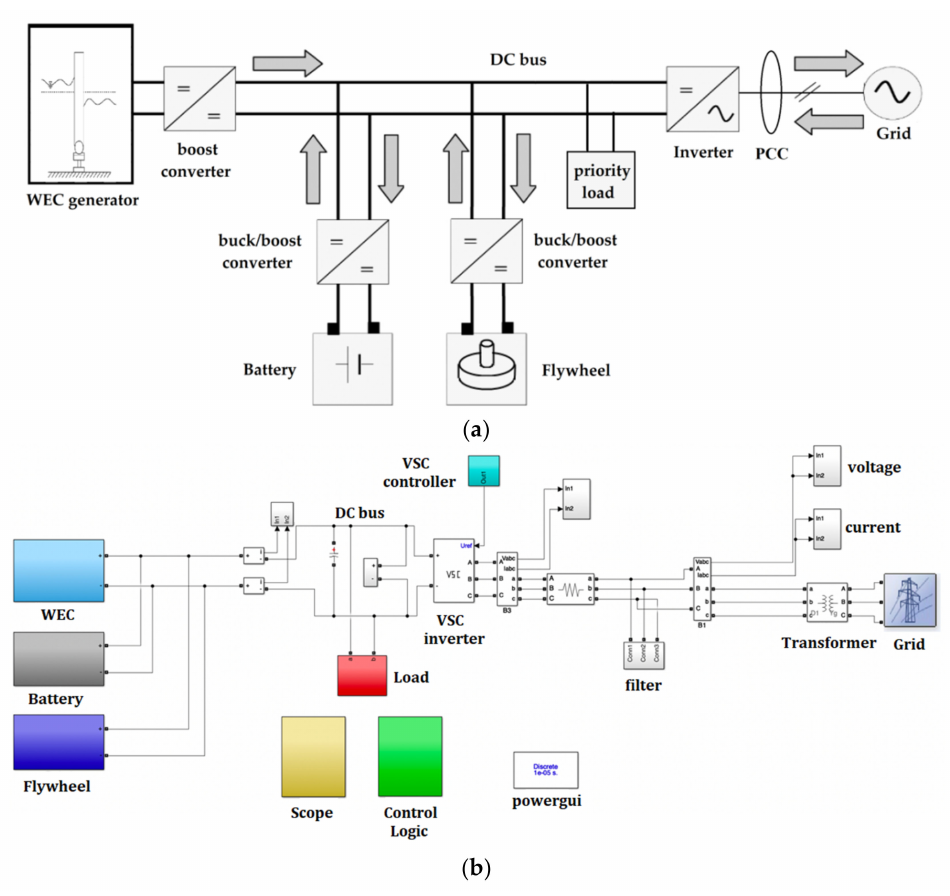
Figure 1. Schematic layout of the modelled system: ( a ) conceptual configuration and ( b ) Sim- scape/SimPowerSystems